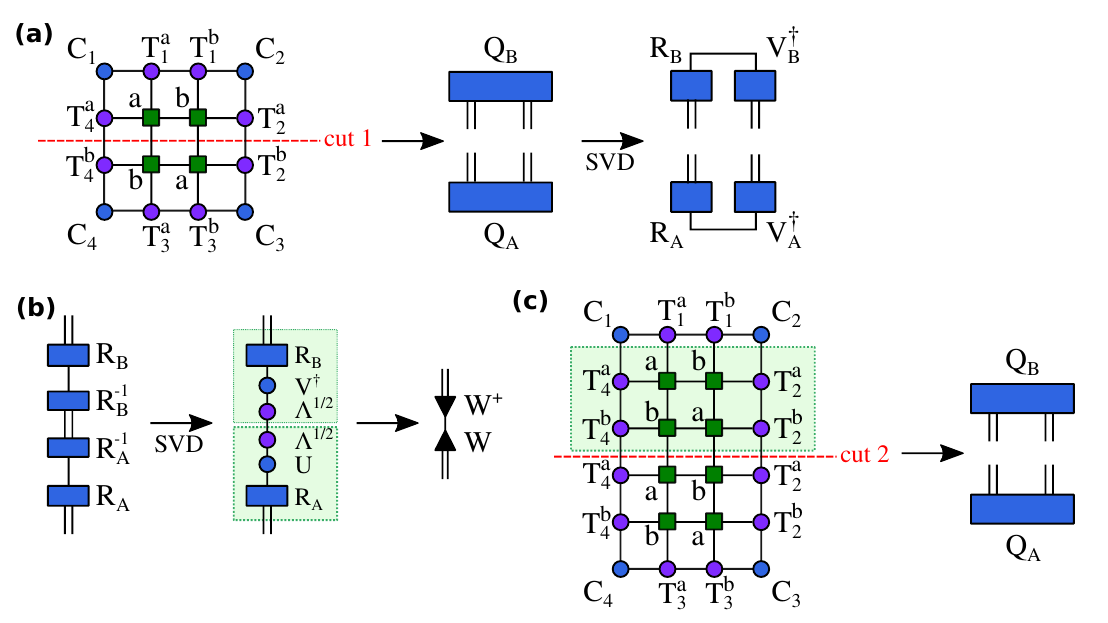
Figure 9: (a,b) The steps to compute W , W + isometries for the bonds split by the ’cut-1’. (c) To compute Z , Z + isometries for the bonds split by the ’cut-2’, we perform a translationally-invariant shift by inserting two extra rows of tensors in the green box, and repeat the steps in